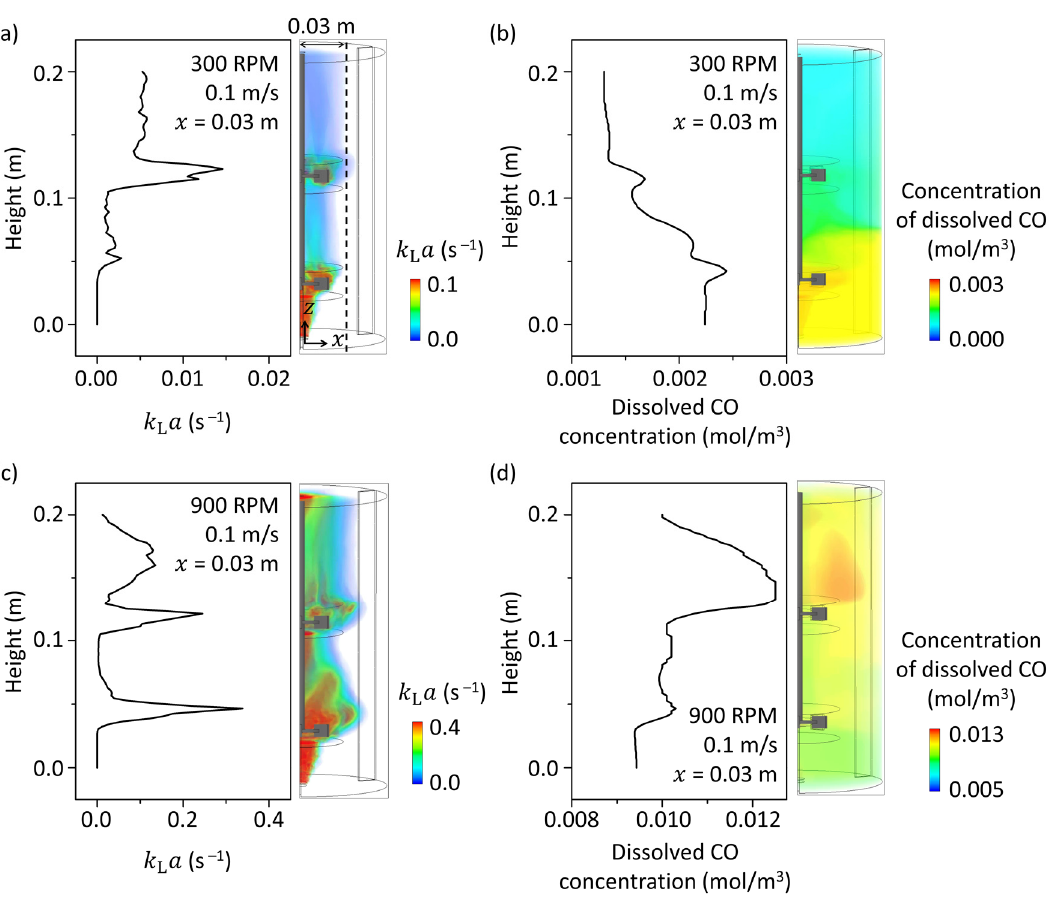
Figure 4. Contour of the volumetric mass transfer coefficient and axial distribution of the dissolved carbon monoxide with different RPMs: ( a , b ) = 300 RPM; ( c , d ) = 900 RPM.